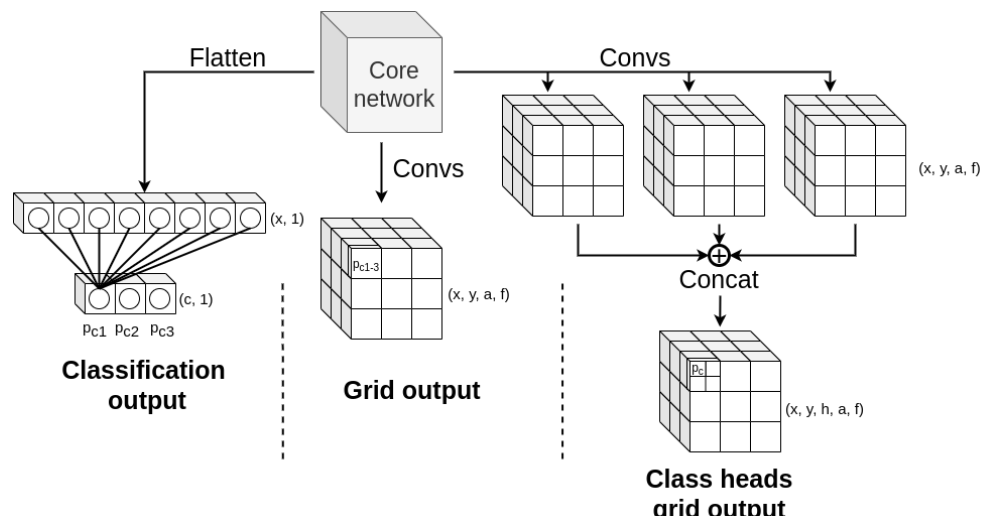
Figure 6. Comparison between different types of model outputs. The classification network outputs a vector of class probabilities, which could be used as a class score as is. The grid tensor output is a more complex structure with four dimensions (x, y, anchors, and features), where class probability values are embedded into feature vector along the fourth dimension. The multi-head output for each class is similar to the grid tensor, but due to the concatenation of all heads it has one additional head dimension (x, y, heads, anchors, and